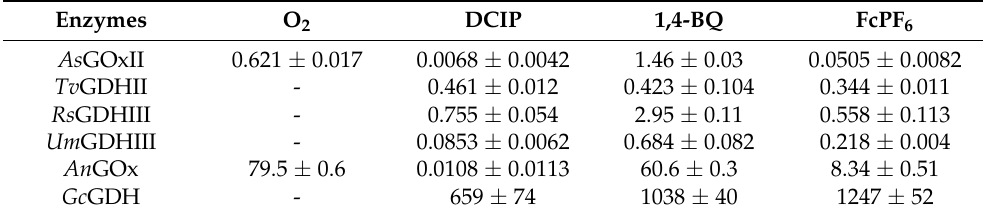
Table 1. Specific activities (U/mg) of various AA3_2 glucose oxidoreductases using D-glucose as electron donor substrate and various electron acceptors.